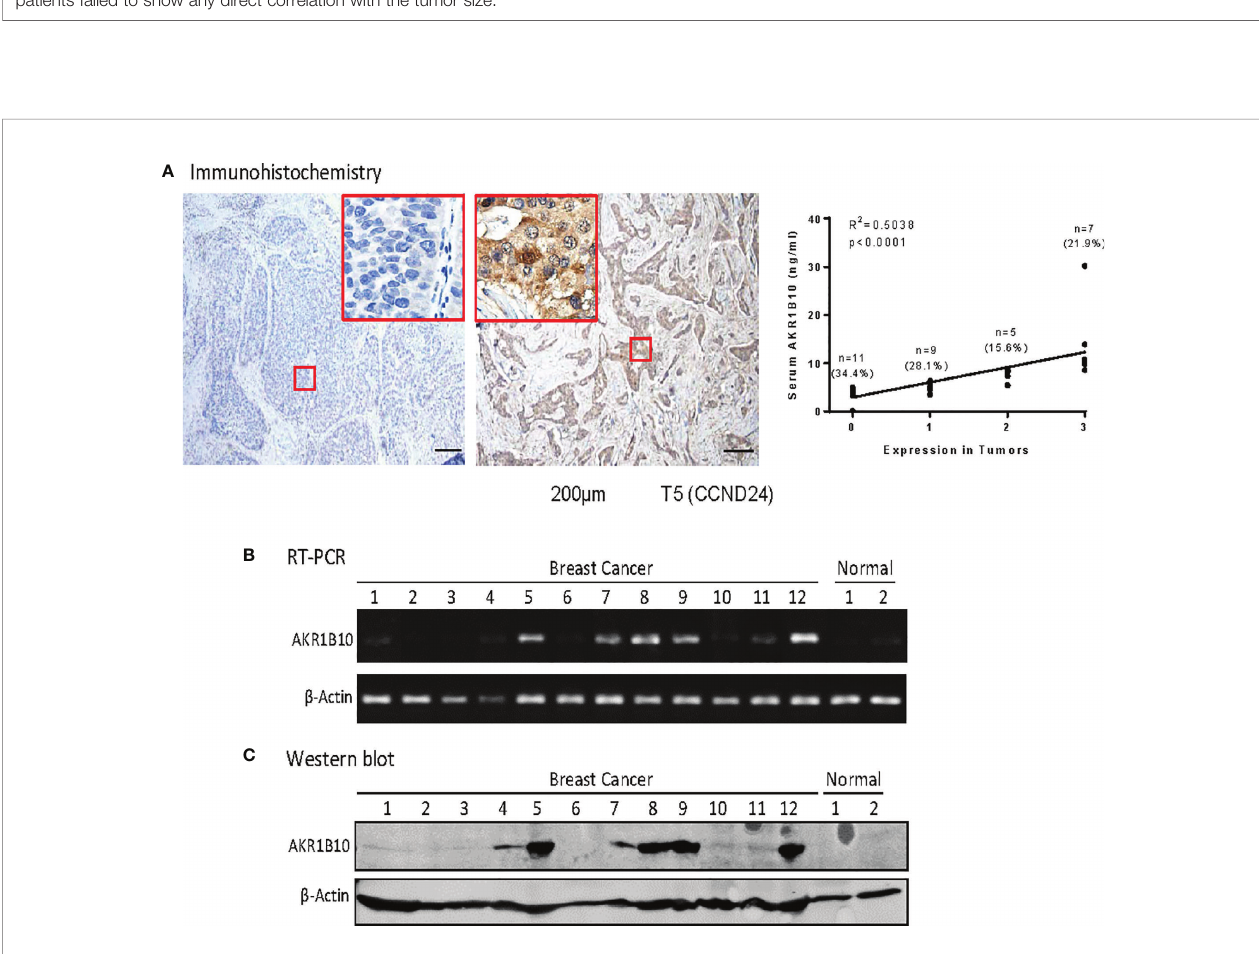
FIGURE 3 | AKR1810 expression in breast cancer tissues. (A) Immunohistochemistry. Paraf fi n embedded tissue sections were used for Immunohistochemical staining of AKR1B10. The serum levels of AKR1B10 were signi fi cantly correlated with its expression in tumor tissues. (B) Semi quantitative RT-PCR for AKR1B10 mRNA and (C) Western blot for AKR1B10 protein. Fresh tissues were collected from some cases to run RT-PCR and Western blot to con fi rm AKR1B10 expression. As compared to tumor specimens, healthy tissues showed very weak expression of AKR1B10 mRNA by PCR (B) and undetectable AKR1B10 protein by Western blot. Breast cancer tissues Line 1to 12: CAND4, CAND8, CAND21, CAND22, CAND24, CAND25, CAND29, CAND33, CAND34, CAND36, CBMR28, CCN4 (a case recruited for neoadjuvant trial); Normal breast tissues Line 1 & 2: normal breast tissues from tissue bank.